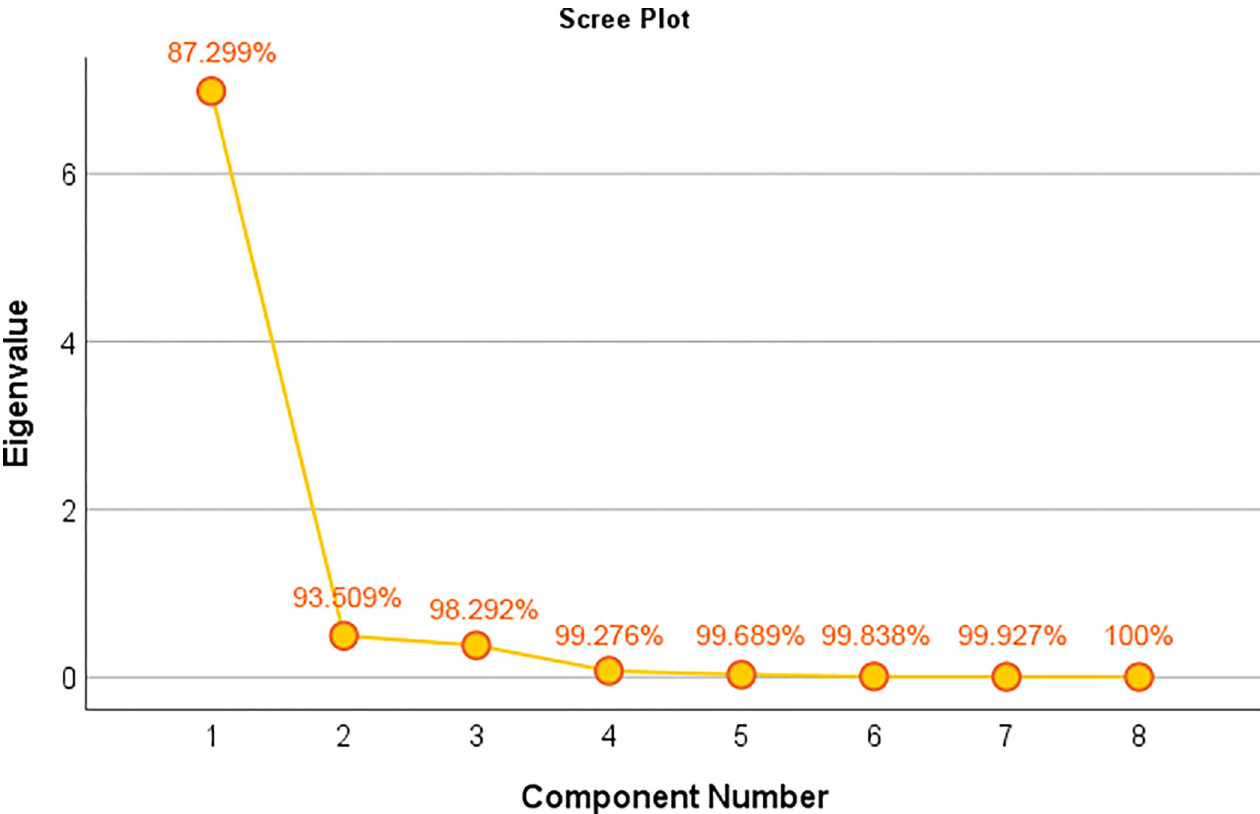
Fig 6. Broken stone diagram of principal components after dimensionality